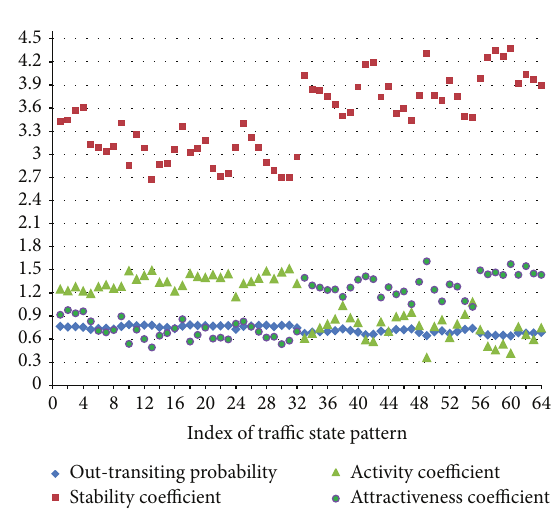
Figure 6: Characteristic values distribution of traffic state pattern